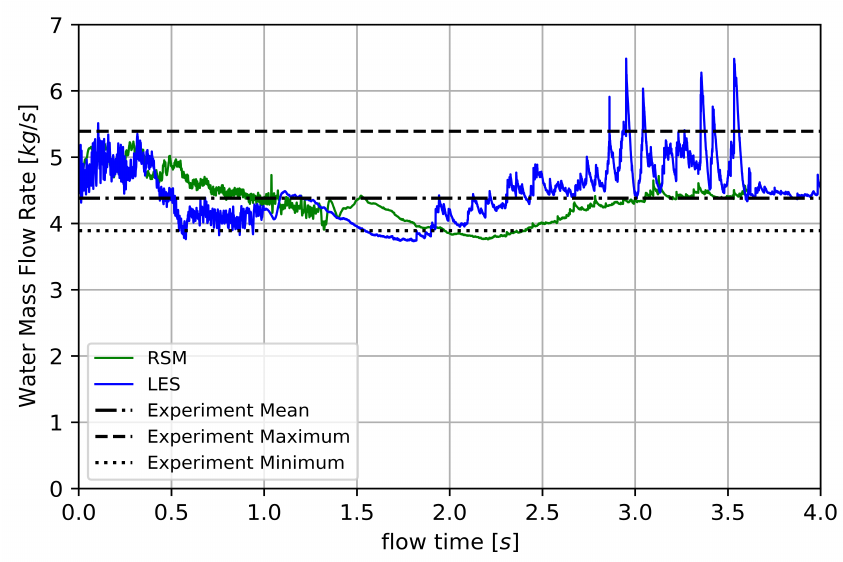
Figure 5. Overflow water mass flow rate as predicted by VOF-DEM models in relation to experiment.